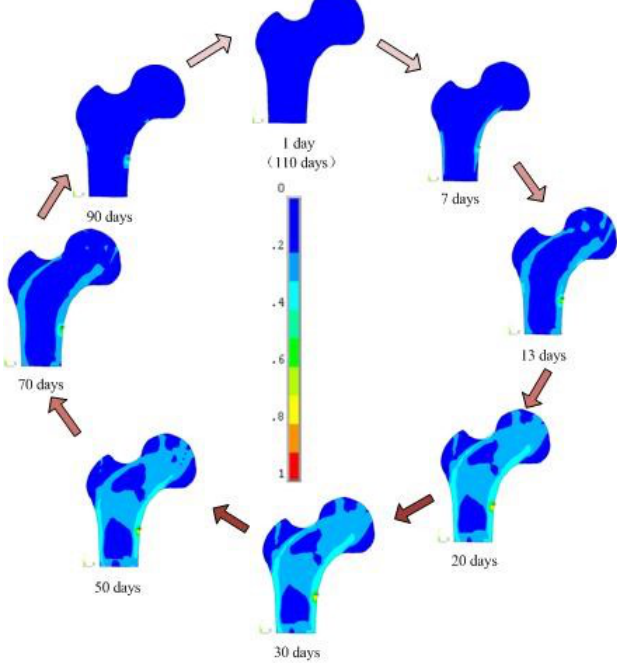
Fig. 5 Change of bone damage in the